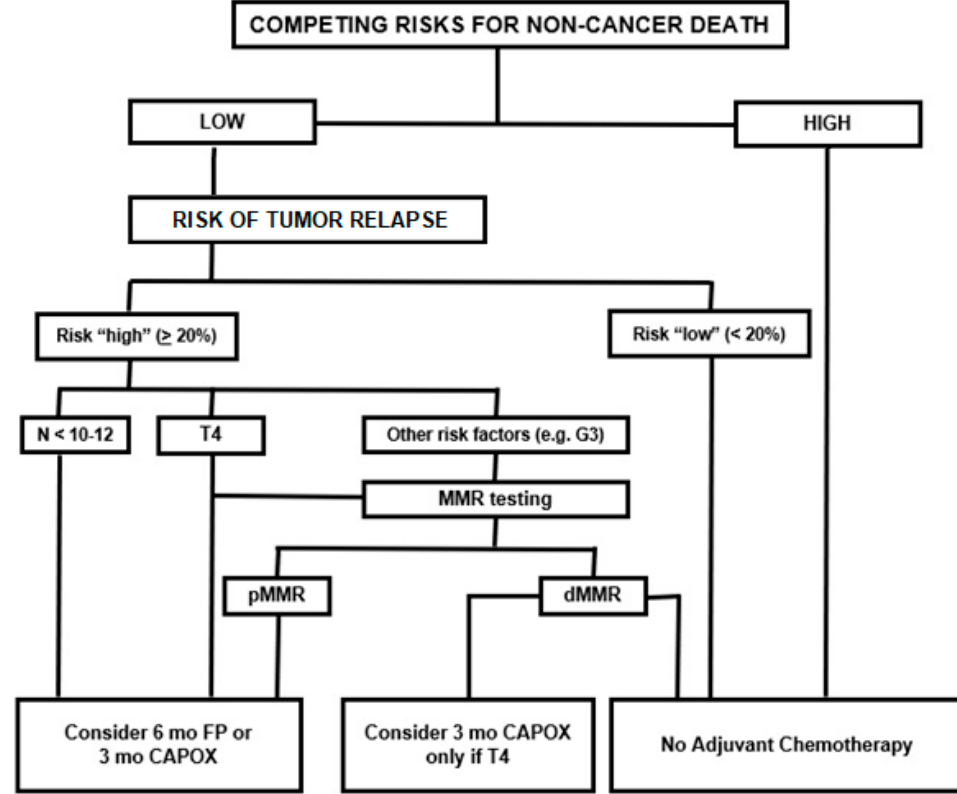
Figure 1. Algorithm for treatment decision in stage II colon cancer. Figure legend: T—tumor, G—grading, N—lymph nodes, mo—months, FP—fluoropyrimidines, CAPOX—capecitabine + oxaliplatin, MMR—mismatch repair, pMMR—proficiency mismatch repair, dMMR—deficiency